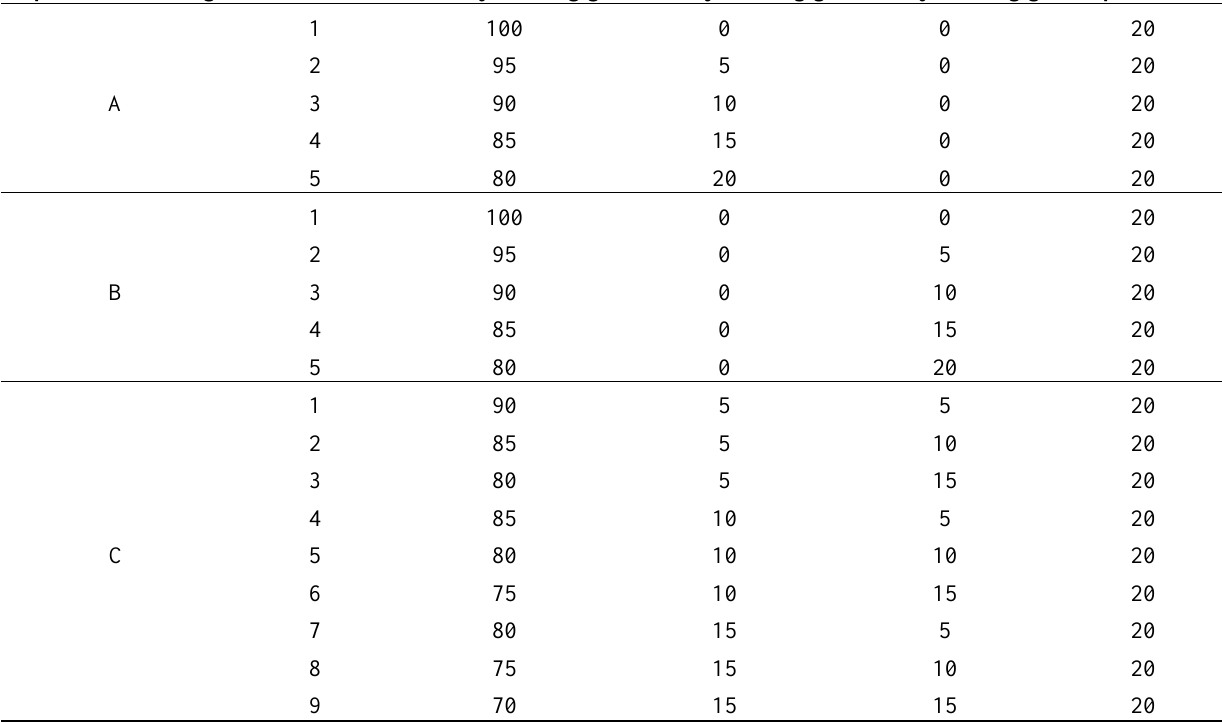
Table 1. Sets of five notoginseng powder (NP) treatments with a single adulterant of Sophora flavescens powder (SFP) (Experimental design A), with a single adulterant of corn flour (CF) (Experimental design B), and with both SFP and CF as adulterants (Experimental design